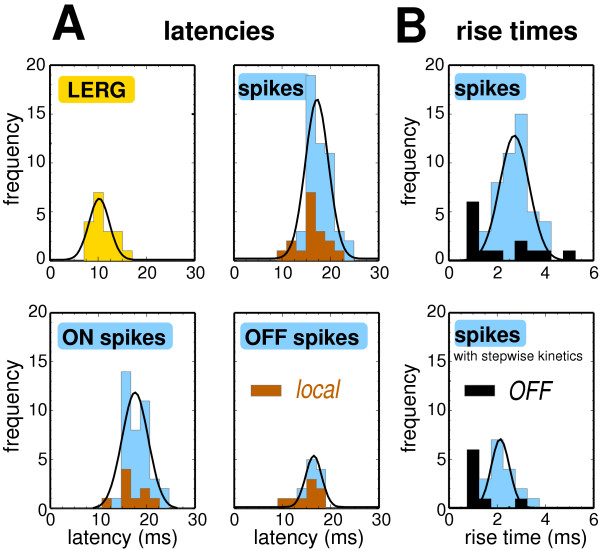
Summary statistics for response latencies and rise times. A: Latencies of LERG-RFs (yellow), pooled spike ON- and OFF-RFs, spike ON-RFs, and spike OFF-RFs (blue histograms with Gaussian fits, N = 18 LERG-RFs in two experiments, N = 53 spike-RFs in three experiments). Brown histograms of data restricted to local spike-RFs. B: Rise times for all spike-RFs (blue) and spike OFF-RFs (black). The upper plot shows pooled data for all three experiments. The lower plot shows data from the two experiments with stepwise response kinetics (experiments 142 and 033). Note here, that the rise times for spike OFF-responses are shorter than for spike ON-responses.